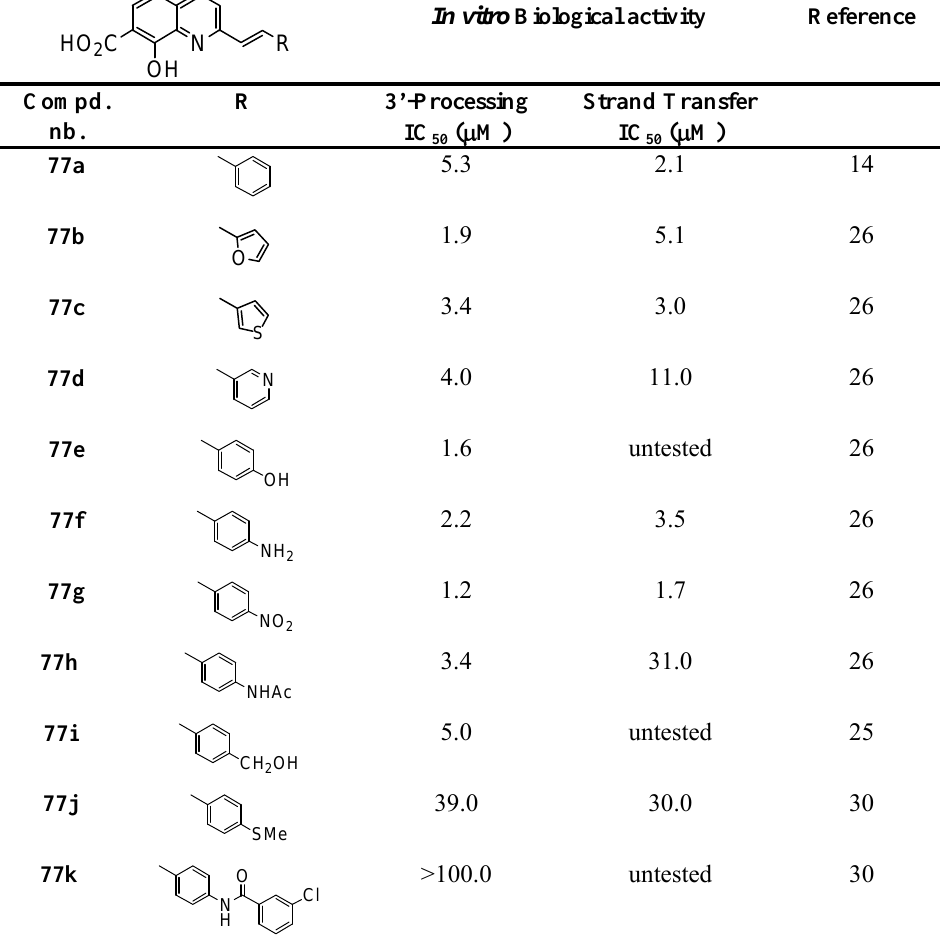
Table 6. Influence of the ancillary ring on the HIV-1 IN inhibitory potency of 8-hydroxy- 2-styryl-quinoline-7-carboxylic acids. In vitro Biological activity Reference RN OHHO 2 C